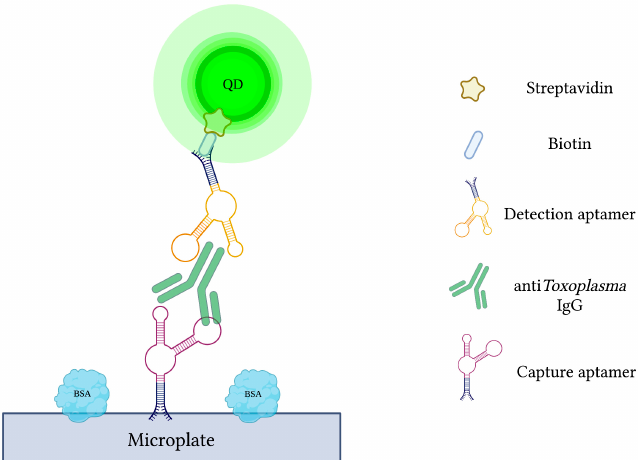
Figure 6. The schematic illustration of the Quantum dots-labeled dual-aptasensor (Q-DAS) for anti- Toxoplasma IgG detection. Capture and reporter aptamers bind to different epitopes of anti- Toxoplasma IgG. Capture aptamers immobilize the IgG while aptamer-labeled quantum dots emit a measurable fluorescence. Adapted with permission from Ref. [71]. 2013, American Chemical Society. Created with BioRender.com (accessed on 19 December 2021).